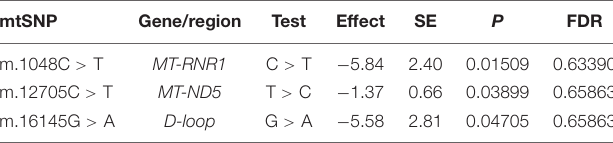
TABLE 4 | Relationships of mtDNA variations with LVEF ( P < 0.05).